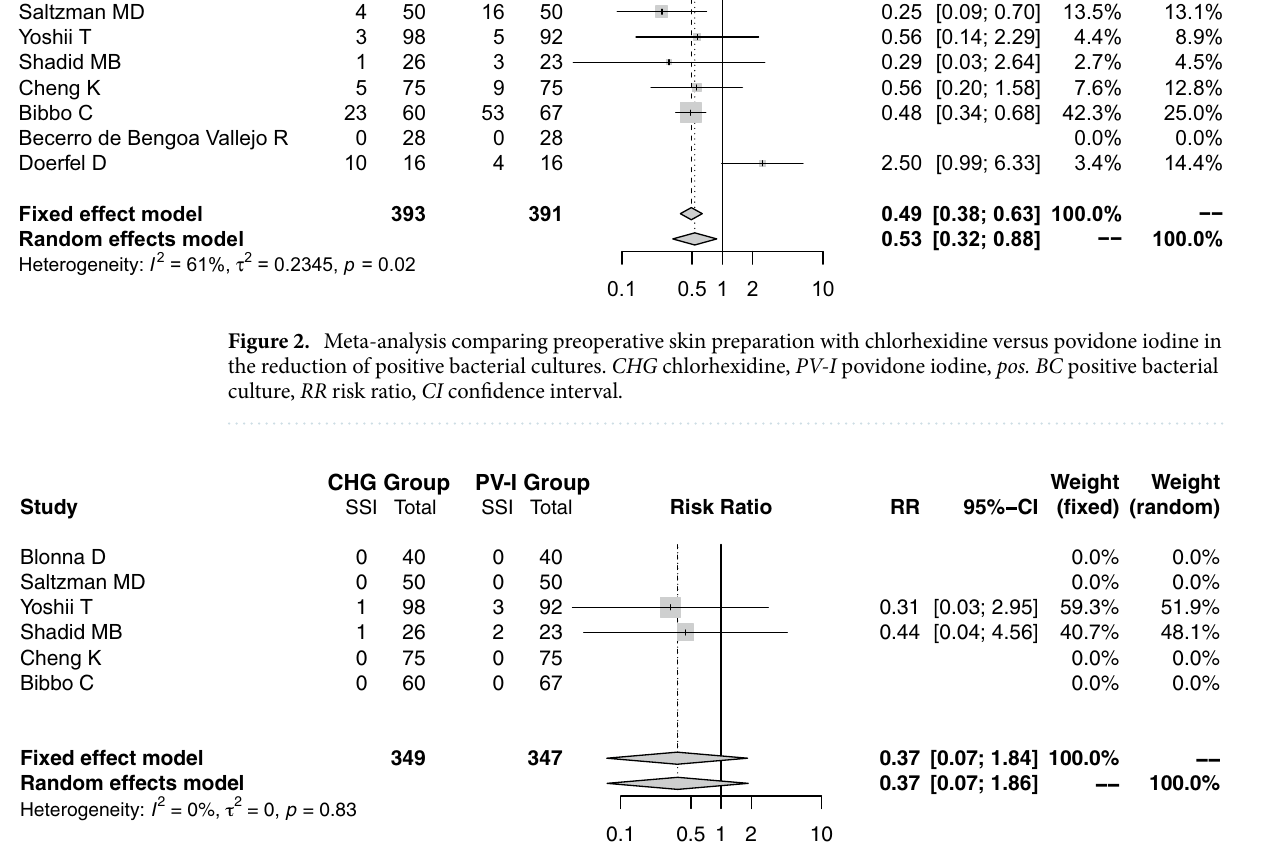
Figure 3. Meta-analysis comparing preoperative skin preparation with chlorhexidine versus povidone iodine in the prevalence of postoperative surgical site infections (surgical studies). SSI surgical site infection, CHG chlorhexidine, PV-I povidone iodine, RR risk ratio, CI confidence